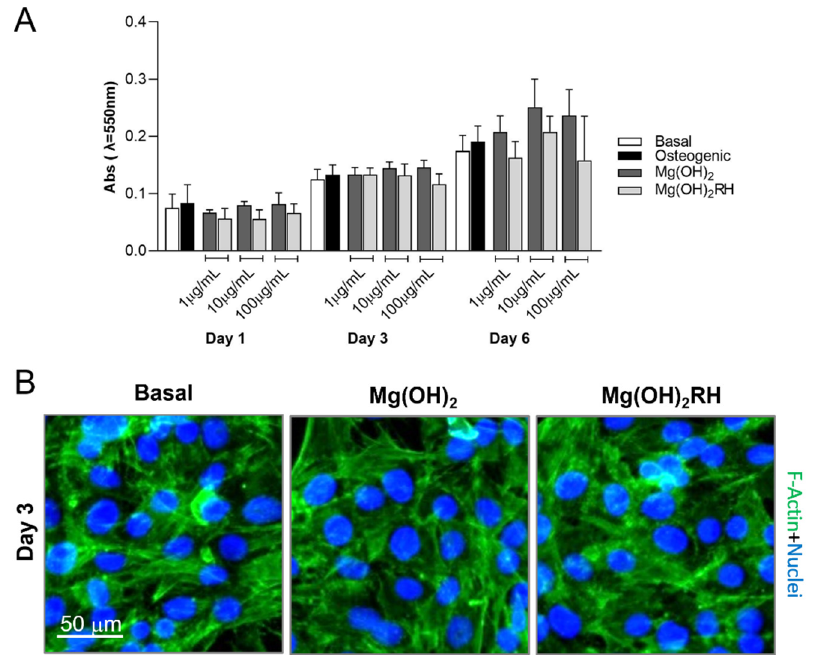
Figure 2. ( A )—cell viability/proliferation (MTT assay) of MG-63 cells cultured in basal and osteogenic conditions, and exposed to Mg(OH) 2 and Mg(OH) 2 RH NPs at 1, 10, and 100 µg/mL, for 1, 3, and 6 days. ( B )—immunostaining of F-actin cytoskeleton (green) and nucleus (blue) of cultures grown in basal conditions and treated with the NPs (10 µg/mL) for 3 days.